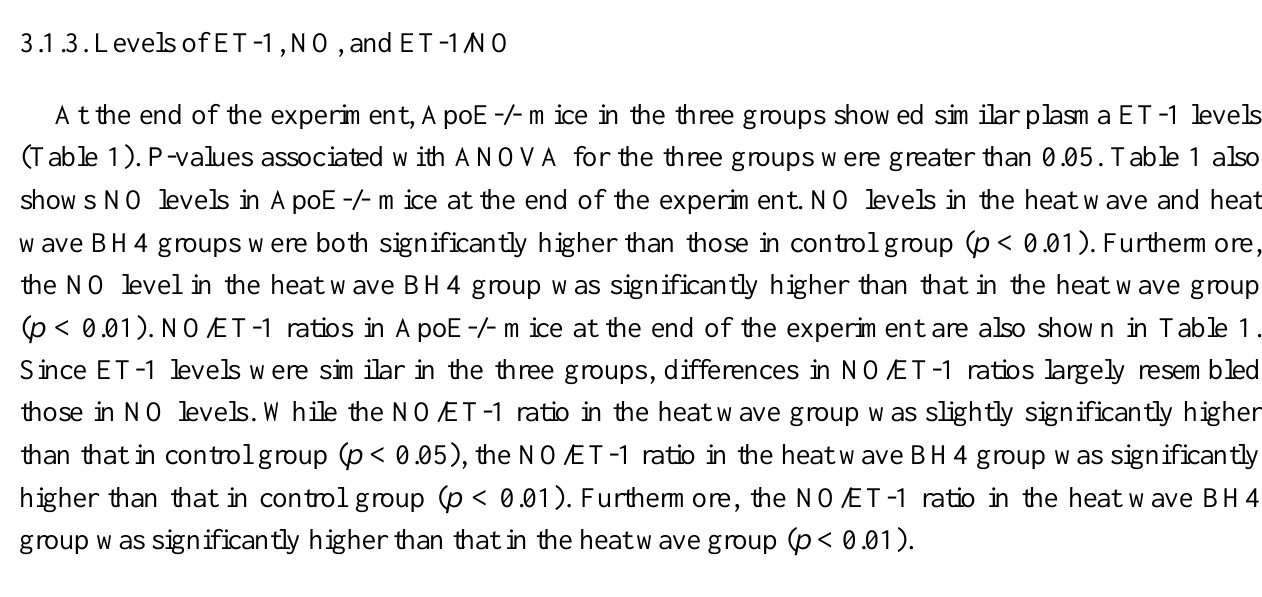
Table 1. ET-1 level, NO level and NO/ET-1 ratio in ApoE-/- mice at the end of the experiments.